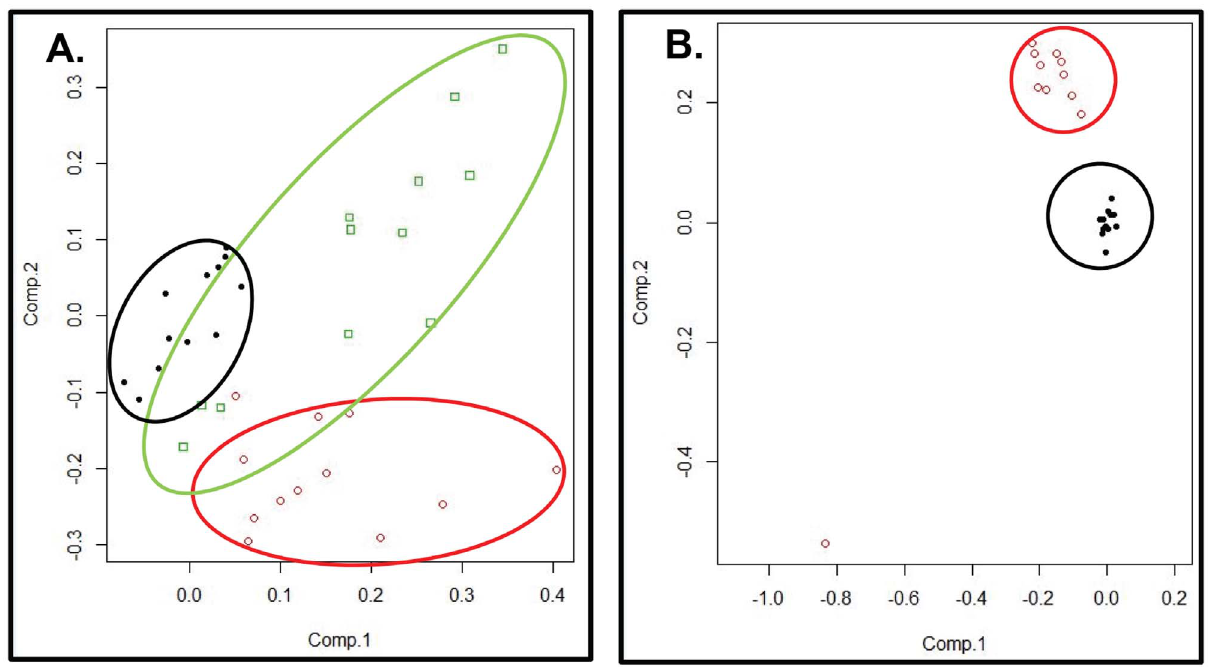
Figure 1. Principal component analyses of the metabolic profiles of the SG series (A) and the JH series (B) show clustering of replicates by resistance phenotype. ( A ) Principal component analysis of the metabolic profiles of isolates from the SG series (SG-S, SG-R and SG- rev) shows a separation of samples (replicates) by resistance phenotype. Specifically, the metabolic profiles corresponding to replicates of the VISA strain, SG-R (red ellipse) cluster separately from those of its parent VSSA, SG-S (black ellipse), while those of SG-rev (green ellipse) cluster between these two, overlapping both. ( B ) Principal component analysis of the metabolic profiles of isolates from the JH series again shows clustering of replicates by phenotype, with both the parent VSSA JH1 (black circles) and VISA JH2 (red circles) forming non-overlapping clusters (though one outlier, JH2-10, is noted).